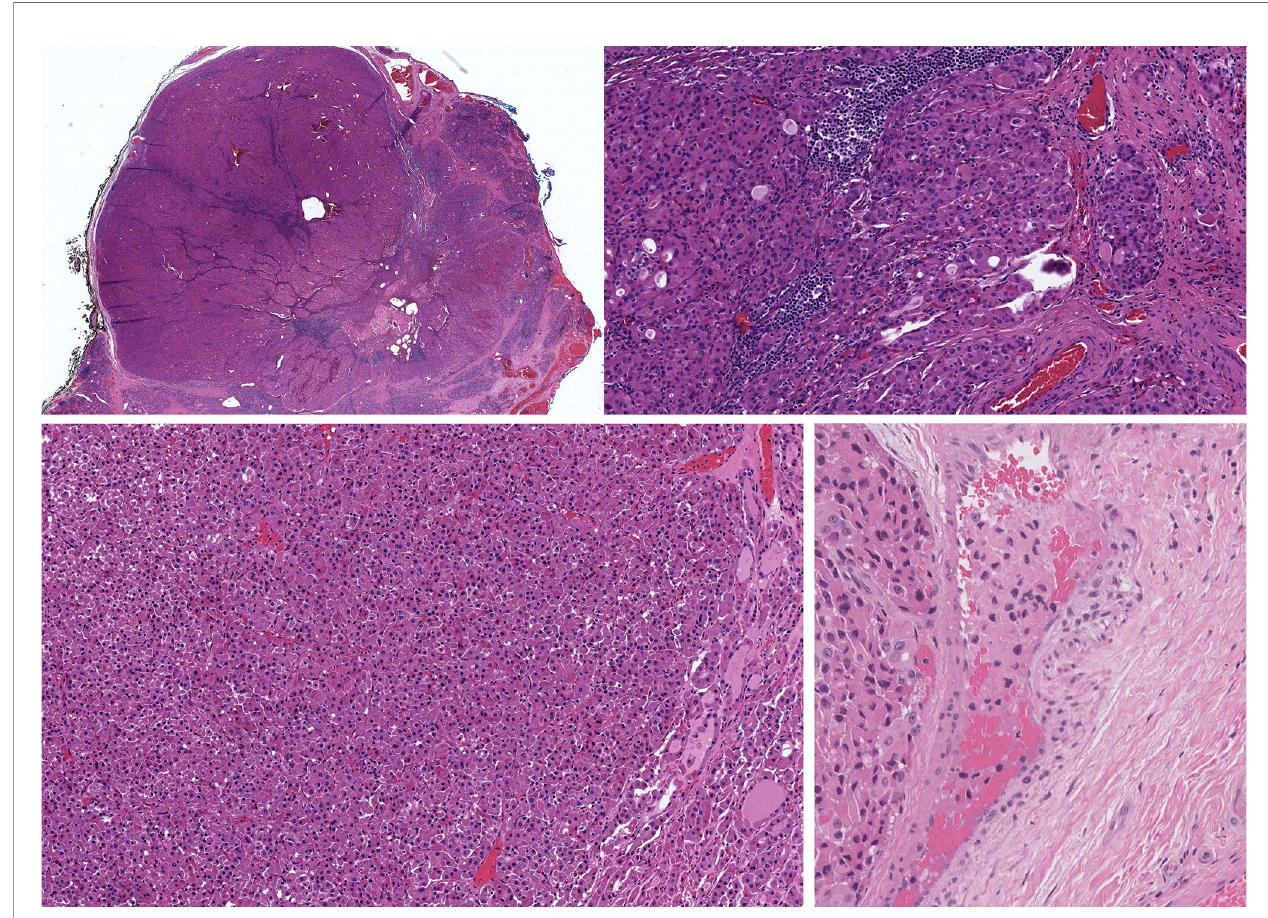
FIGURE 8 | Oncocytic Poorly Differentiated Thyroid Carcinoma. These oncocytic tumors are widely invasive (top left) with multifocal capsular invasion (top right) and prominent solid architecture with only focal residual follicles (bottom left). Vascular invasion is readily identi fi ed (bottom